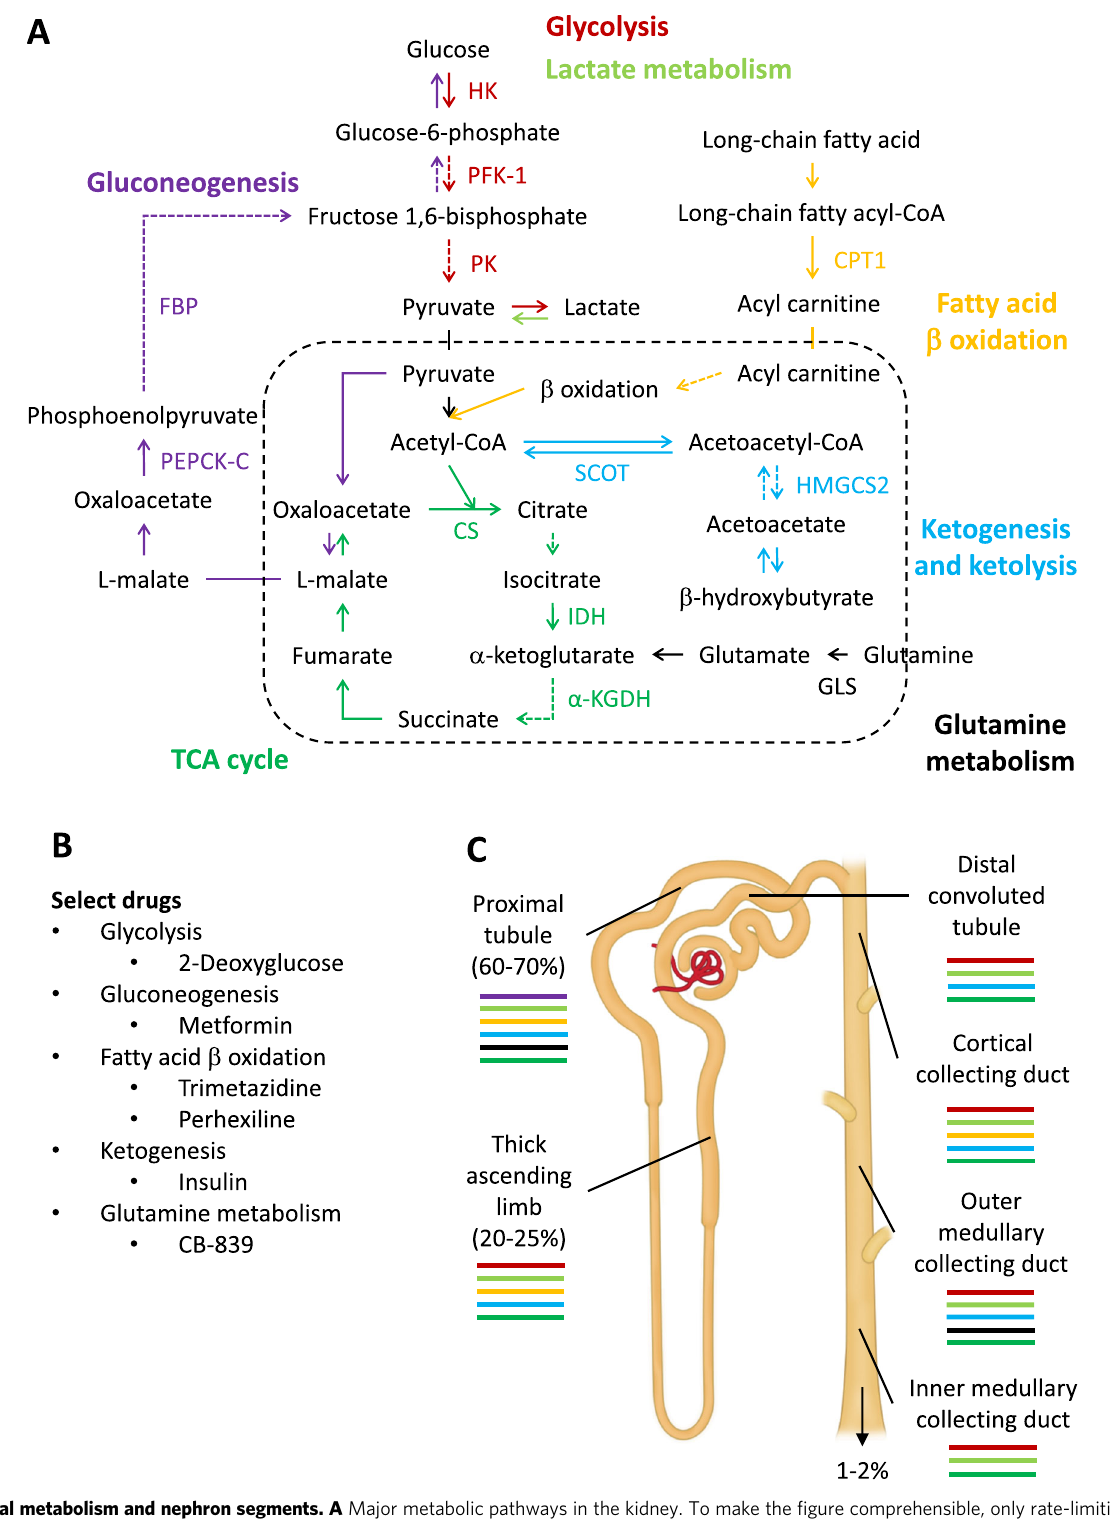
Fig. 1 Renal metabolism and nephron segments. A Major metabolic pathways in the kidney. To make the fi gure comprehensible, only rate-limiting or key enzymes are shown, and arrows that contain multiple enzymatic steps are shown as dashed arrows. The box surrounded by the dashed line indicates mitochondria. FBP fructose 1,6-bisphosphatase, PEPCK-C cytosolic phosphoenolpyruvate carboxykinase, HK hexokinase, PFK-1 phosphofructokinase-1, PK pyruvate kinase, CPT1 carnitine palmitoyltransferase I, HMGCS2 mitochondrial HMG-CoA synthetase, SCOT succinyl-CoA:3-ketoacid-CoA transferase, GLS glutaminase, CS citrate synthase, IDH isocitrate dehydrogenase, α -KGDH α -Ketoglutarate dehydrogenase. B Examples of approved or investigational drugs targeting the metabolic pathways. C Major metabolic pathways in nephron segments. Colors of bars correspond to the colors of pathway names in panel A. The percentages indicate the percent of the fi ltered sodium reabsorbed or excreted.